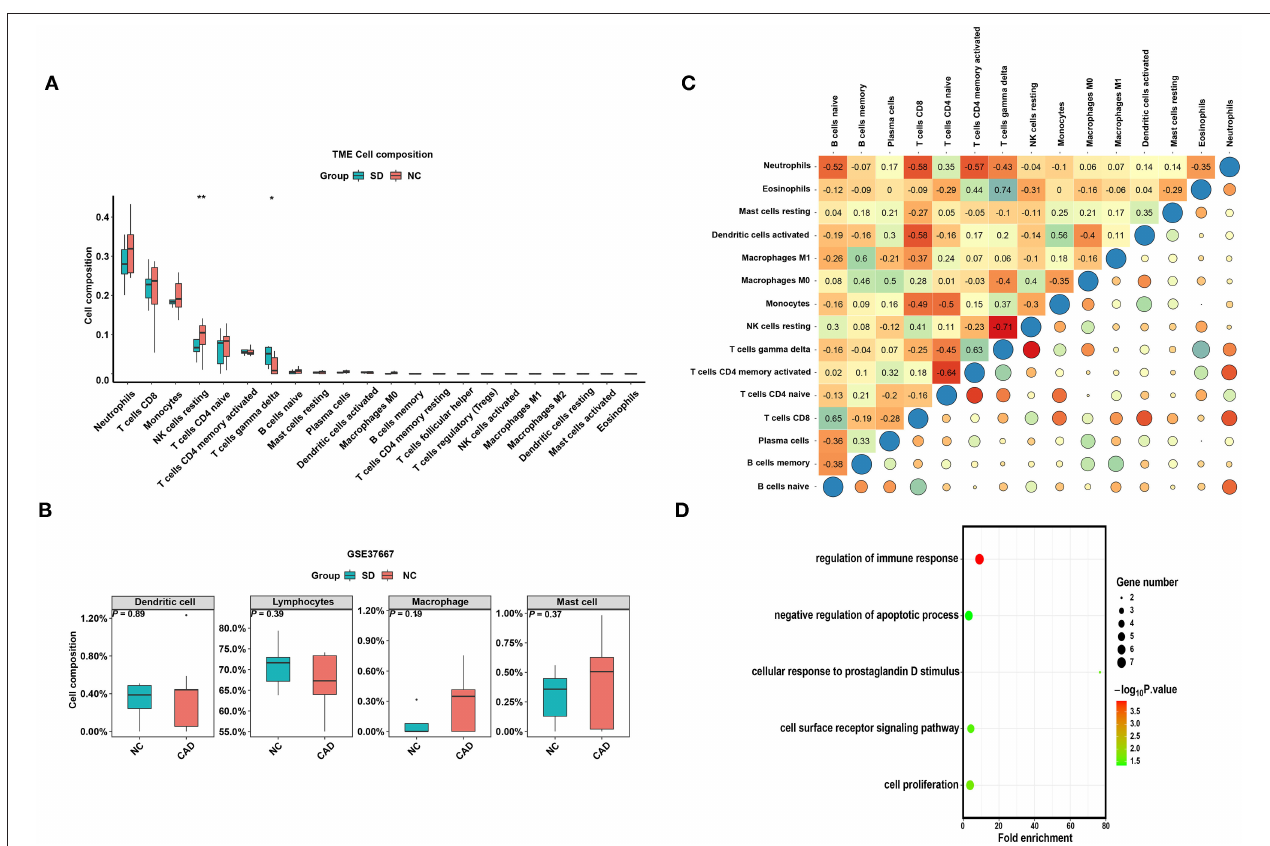
FIGURE 6 | The distribution of 22 types of immune cells between the SD and control samples. (A) Violin plot of 22 types of immune cells differentially enriched between the SD and negative control (NC) samples in the GSE37667 dataset. (B) Violin plot of four aggregated immune cell types differentially enriched in the GSE37667 dataset. (C) Heatmap of correlation of 22 types of immune cells in the GSE37667 dataset. The size of the colored squares represents the strength of the correlation. Darker color implies stronger association. (D) Biological process of SD-DEGs from the GSE37667 dataset. * P < 0.05; ** P <